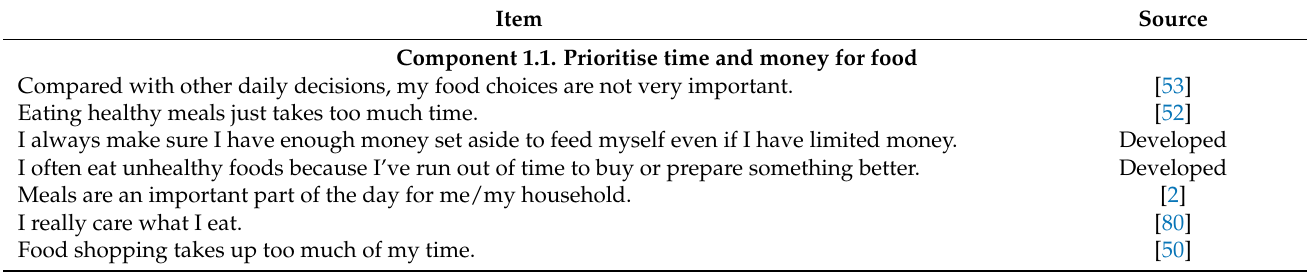
Table 3. International Food Literacy Survey items within each component achieving consensus (ie CVI score ≥ 0.71) in Round two of the Content Validity Study. Item Source Component 1.1. Prioritise time and money for food Compared with other daily decisions, my food choices are not very